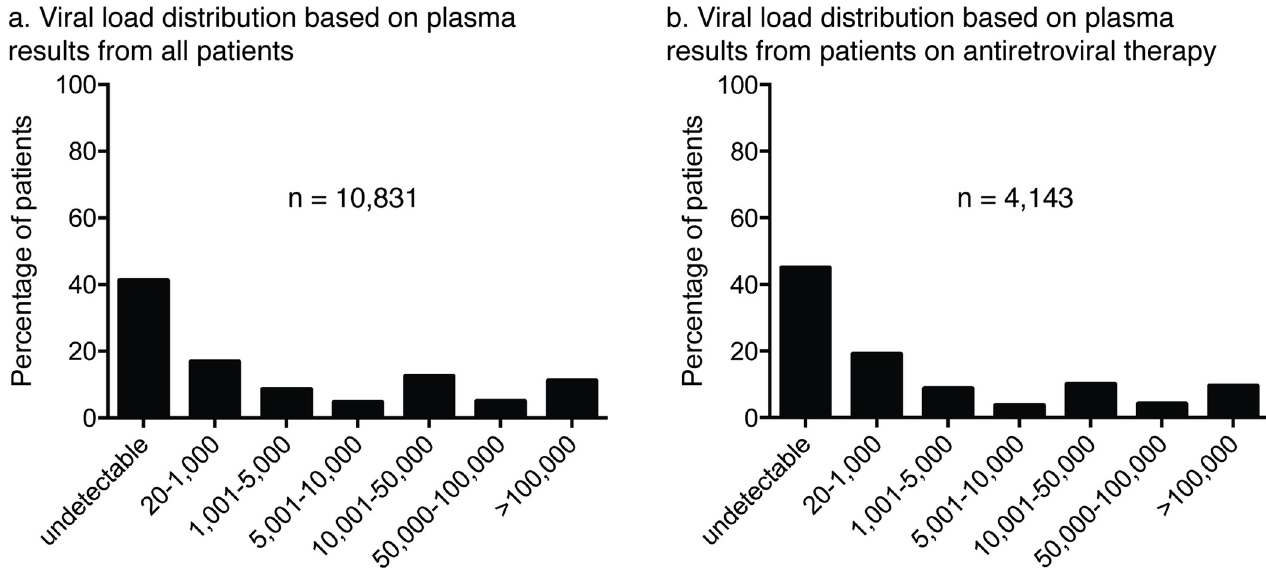
Fig 2. Patient plasma viral load distribution from all studies (a) and including only patients on antiretroviral therapy (b).